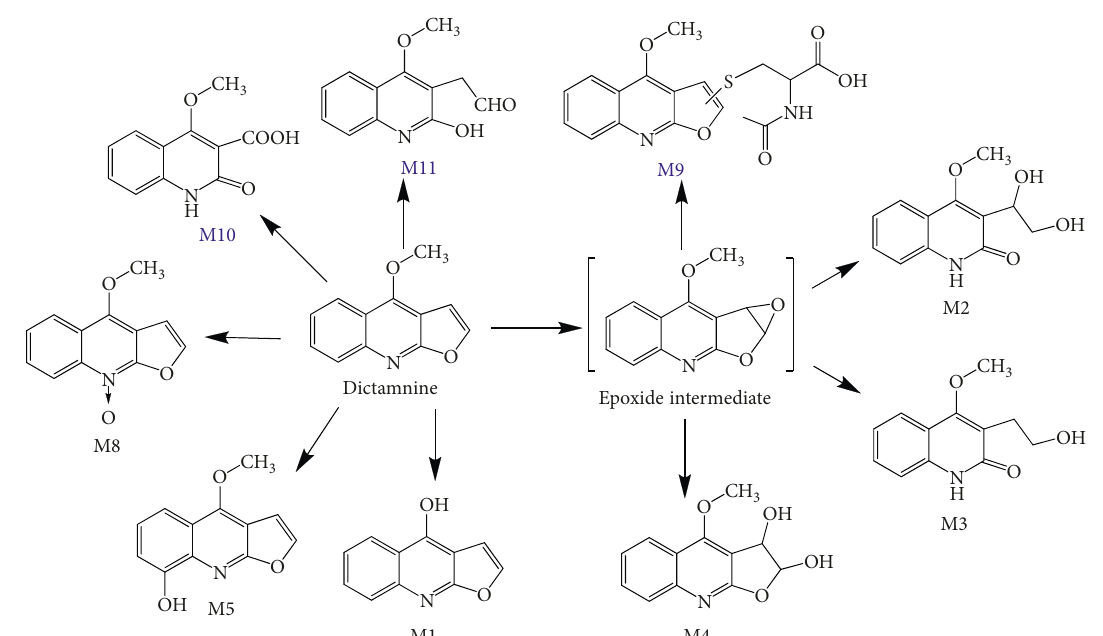
Figure 6: Chemical structures of the nine identified metabolites and their potential metabolic pathways in